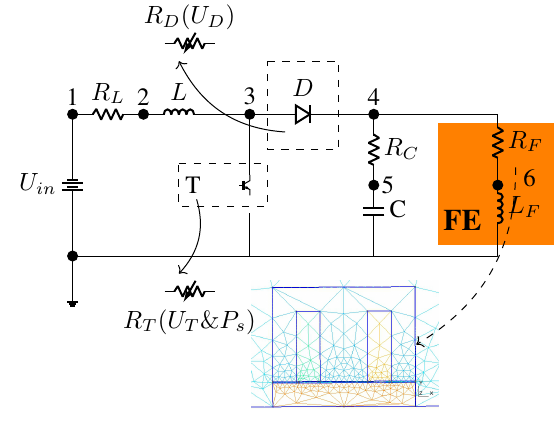
Figure 3: Open loop DC-DC boost-converter model cou- pled with an FE air-gapped inductor. A pulse width mod- ulation (PWM) is fed to the transistor. Classical models of the diodes and transistors include variable resistances as function of branch voltages ( U T , U D ) and the switching pe- riod ( P s ) are